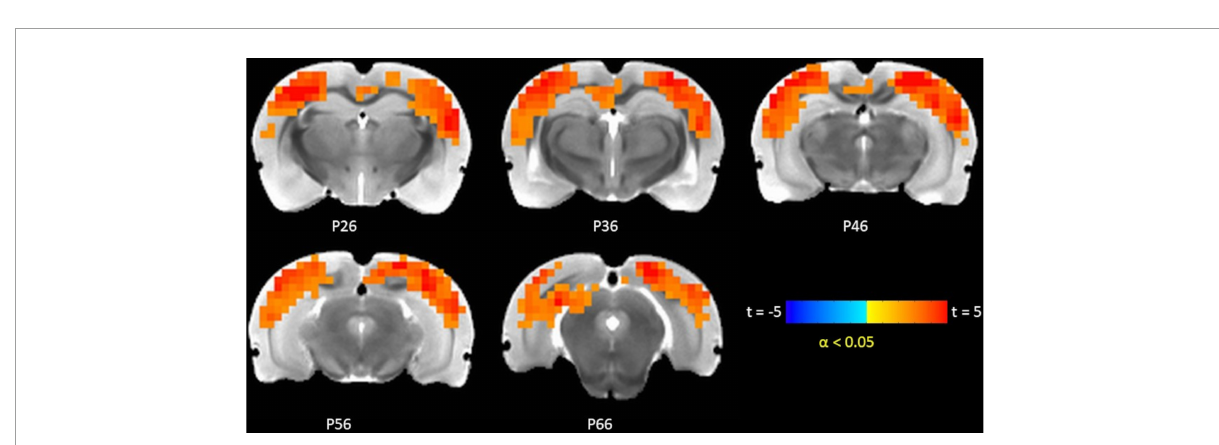
FIGURE4 TTA-P2 vs. Baseline t -statistic maps highlighting regions with enhanced functional connectivity (FC) to right auditory cortex region of interest (ROI) after TTA-P2 administration. The slice-location coordinates are in Paxinos space. Left hemisphere is on the left-hand side of the